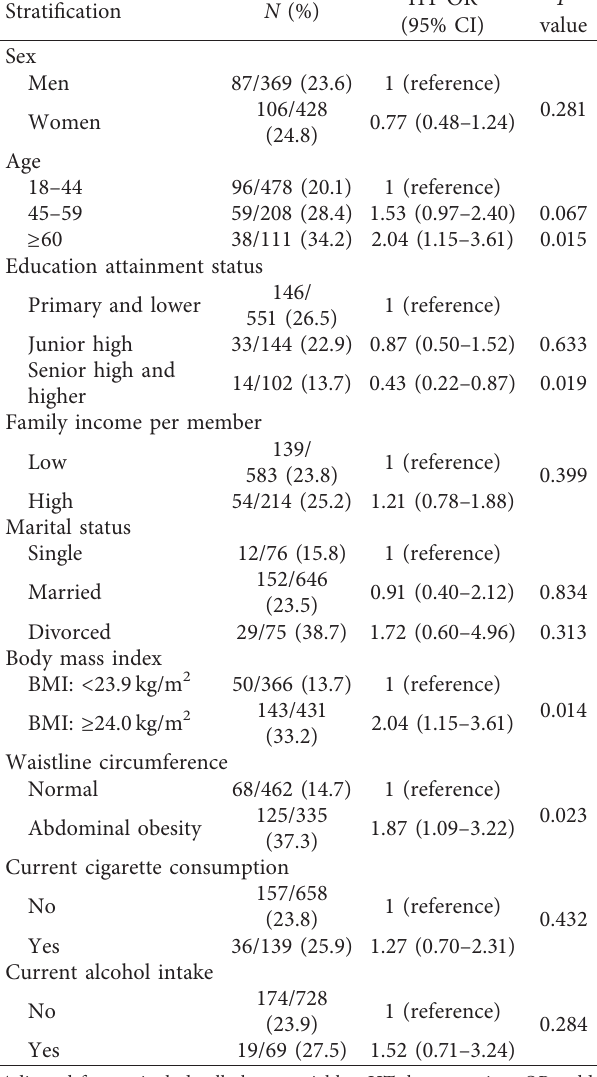
Table 4: Factors associated with prehypertension from study population by multiple logistic regression.